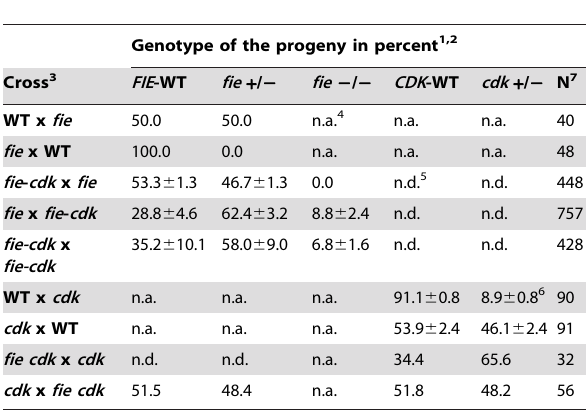
Table 1. Segregation